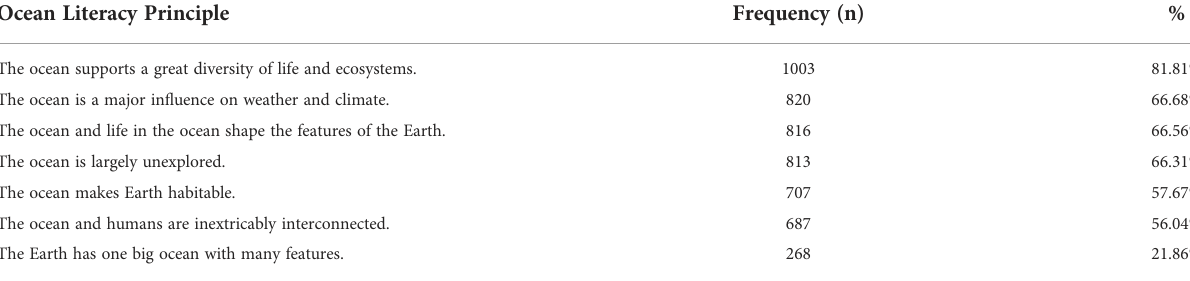
TABLE 2 Knowledge of Ocean Literacy Principles among participants ( N = 1226 ). Ocean Literacy